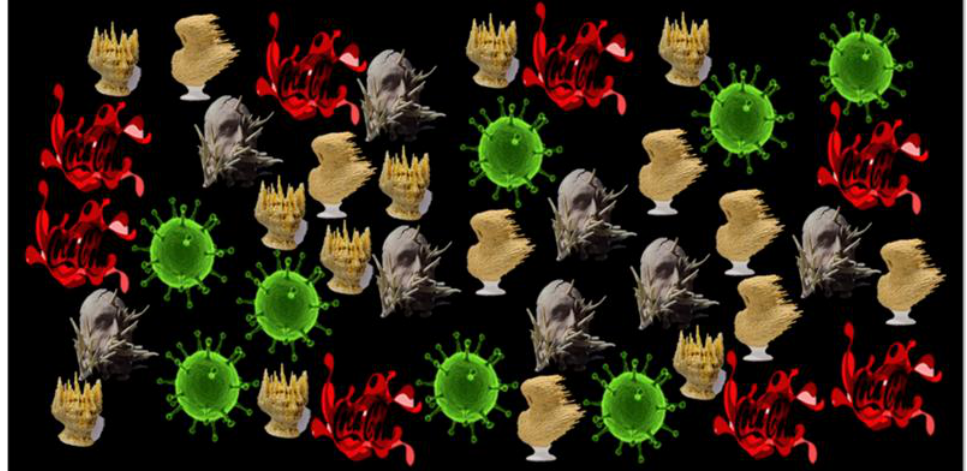
Figure 17. Solution found by the ILS algorithm when inserting 50 pieces for the A0 instance, consuming 4 h of processing time.